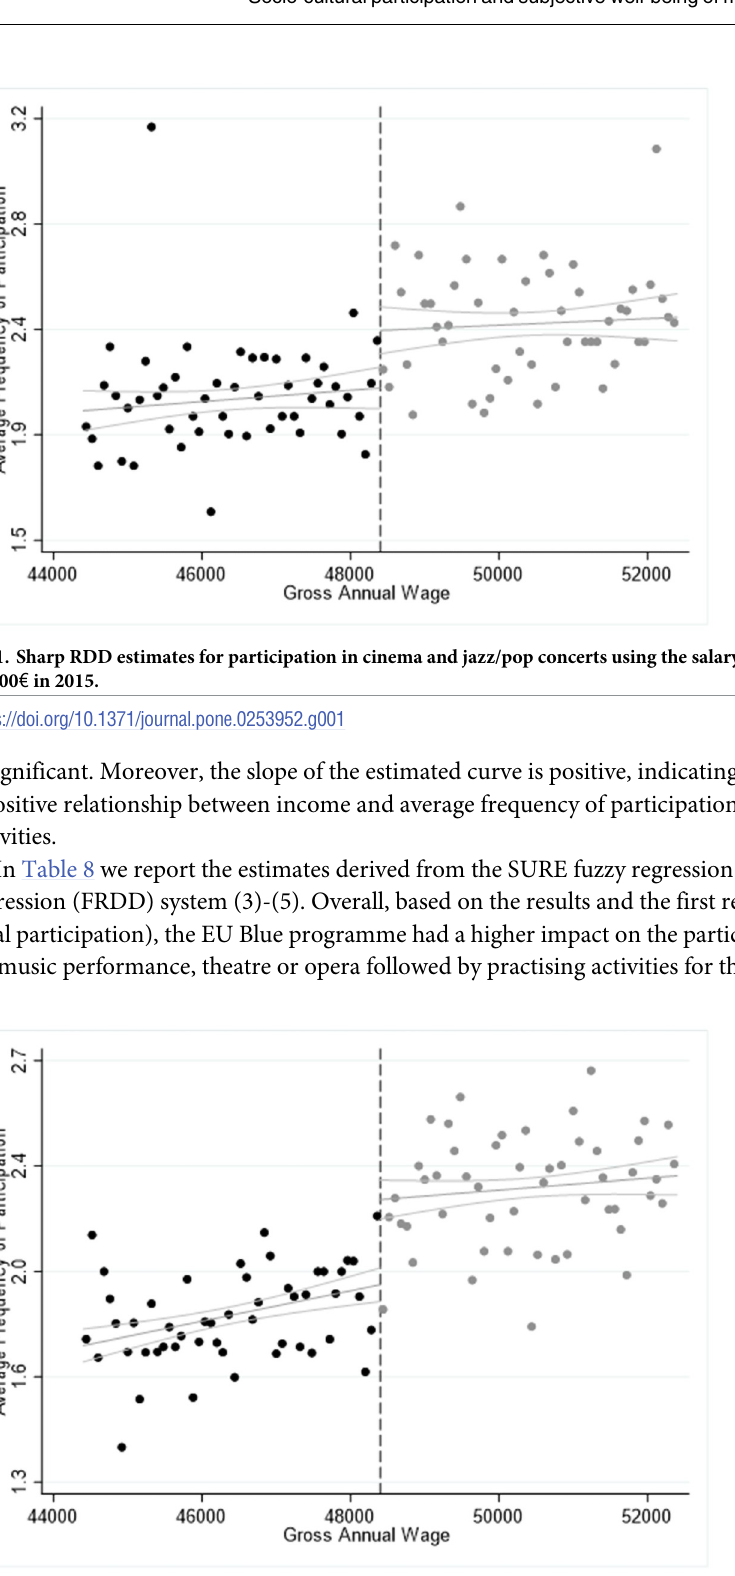
Fig 2. Sharp RDD estimates for participation in classical music performance, opera or theatre using the salary threshold of 48,400 € in 2015.